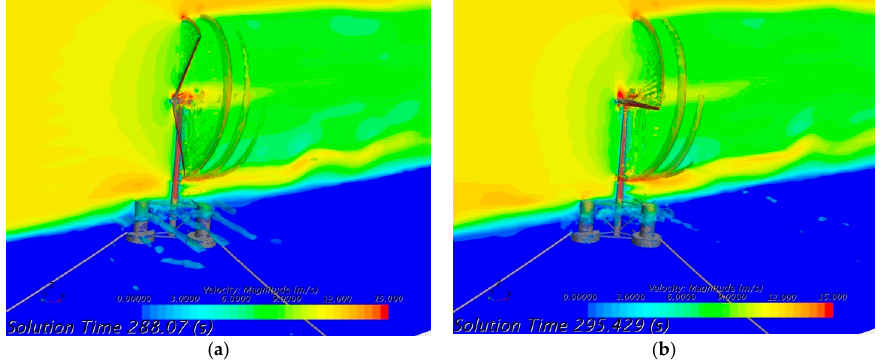
Figure 14. Instantaneous iso-velocity contours within one period: ( a ) upwind direction movement; ( b ) downwind direction movement.